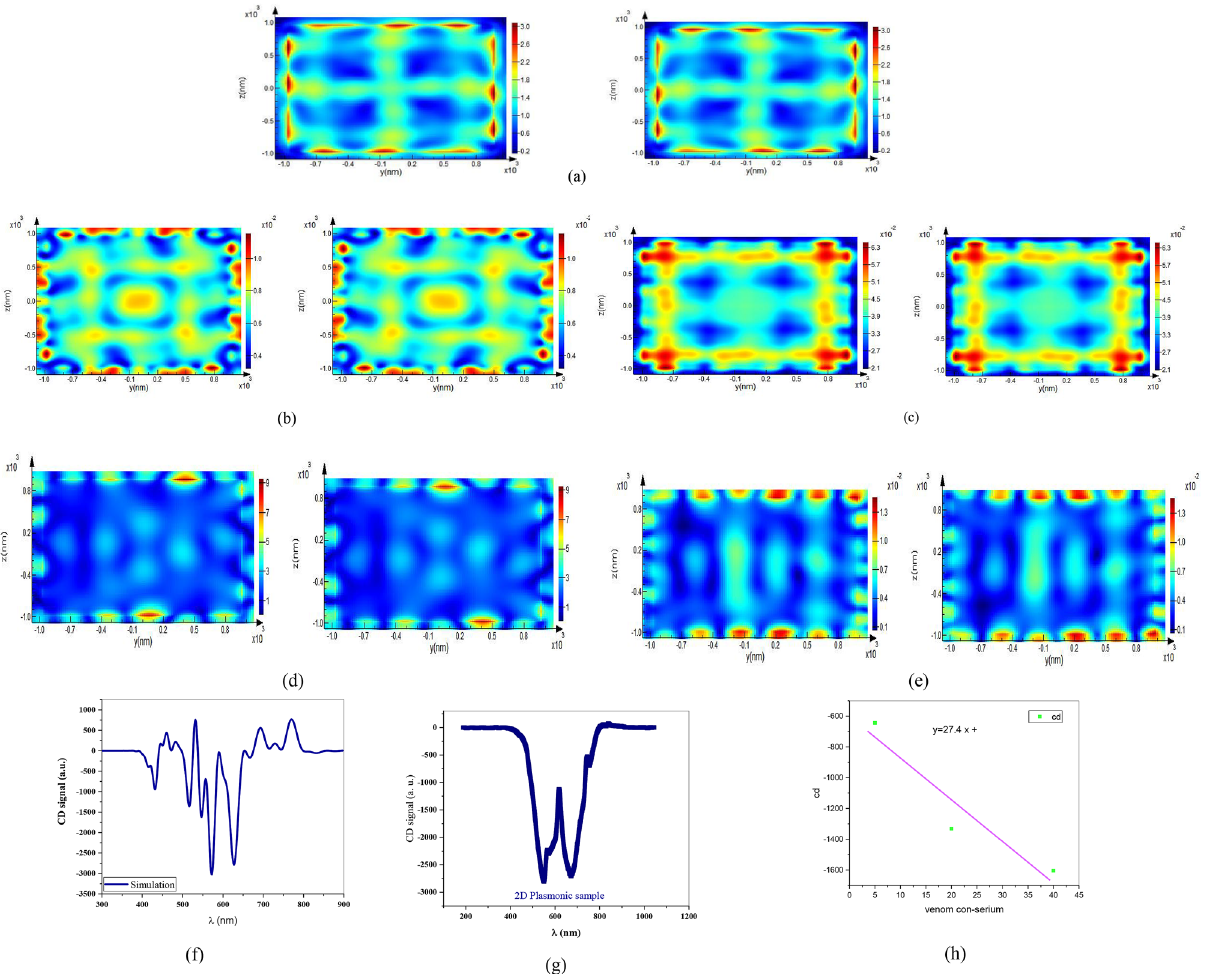
Figure 3. Magnetic and Electric field distributions of sample for right and left circular polarizations for ( a ) LCP-T-E and RCP-T-E and ( b ) LCP-T-H and RCP-T-H and ( c ) LCP-R-H and RCP-R-H and ( d ) LCP-T-E and RCP-T-E for normal incidence and ( e ) LCP-T-H and RCP-T-H for 5-degree incidence angle. ( f ) Simulation of CD signal, ( g ) measured CD signal in normal incidence and ( h ) sensitivity diagram of the